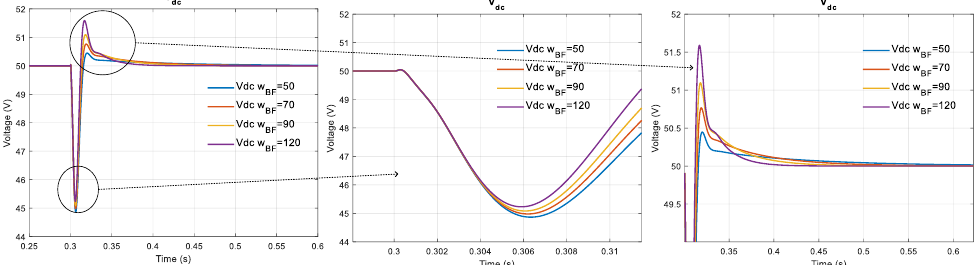
Figure 10. Simulation results: influence of the value of ω BF on the output voltage V dc when the rms grid voltage drops from 55 V to 40 V with the output voltage regulation at 50 V. Parameters are listed in Tables 1 and